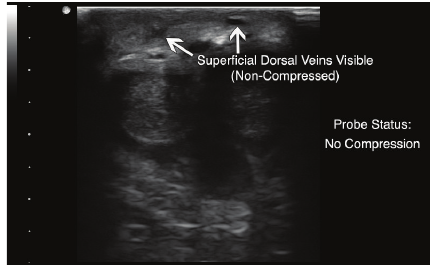
Figure 1: Noncompressed view of superficial dorsal veins with hypoechoic right sided vessel, suggesting superficial thrombophle- bitis (depth set at 4 cm).